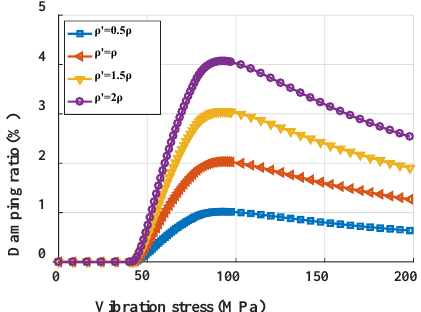
Figure 24. Damping characteristics at different densities of ring for labyrinth seal.